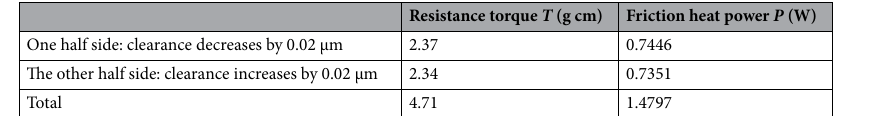
Table 4. Gas film characteristics of two half sides at the same end of the rotor with 0.02 μm radial